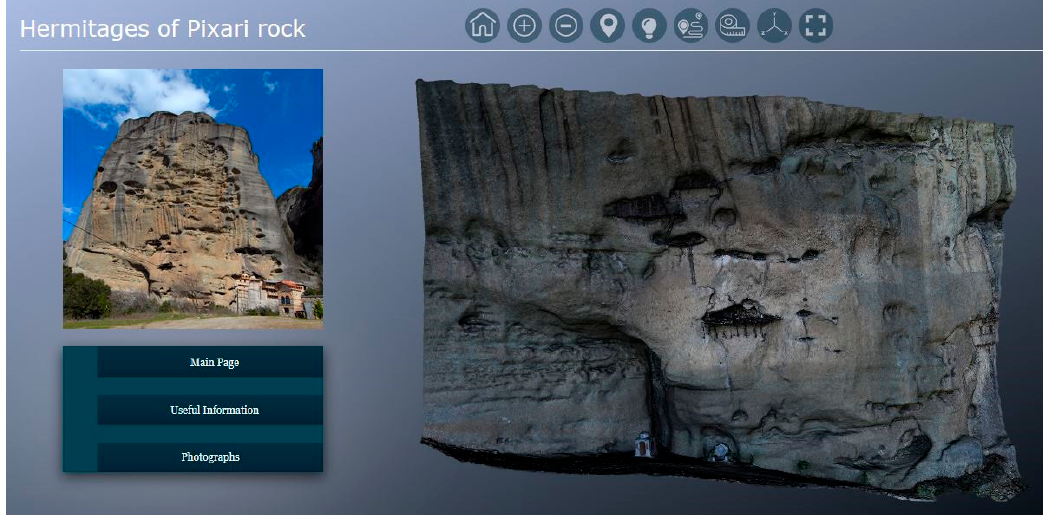
Figure 8. The second page of the 3D platform that hosts the documentation data of Pixari rock.